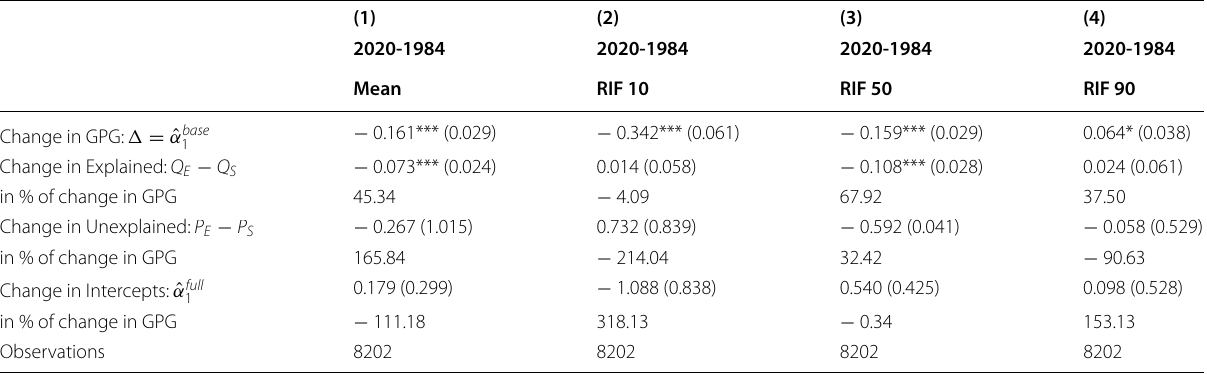
Table 3 Aggregate double decomposition of the change in the explained component and the gender pay gap (GPG) 2020‑1984 at the mean and selected